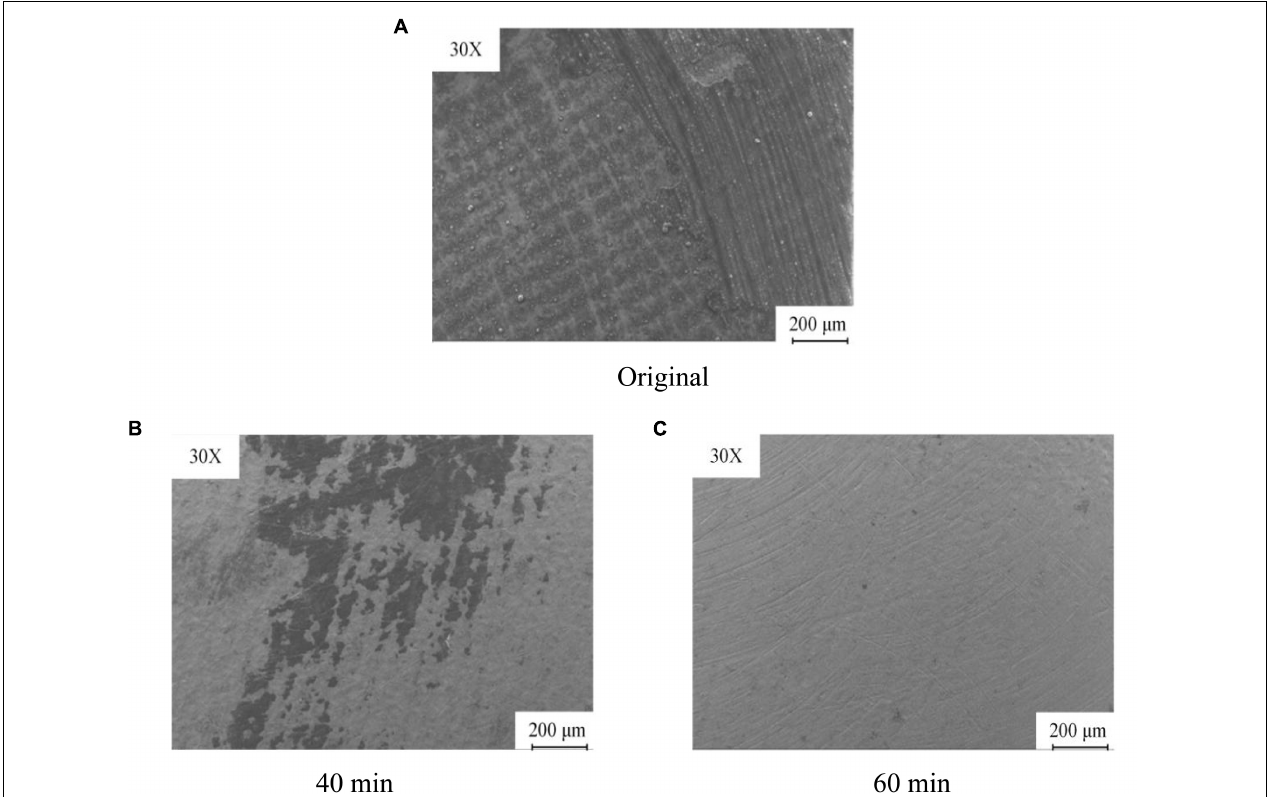
FIGURE 12 | Microstructure after CAMG. (A) Original. (B) 40 min. (C) 60